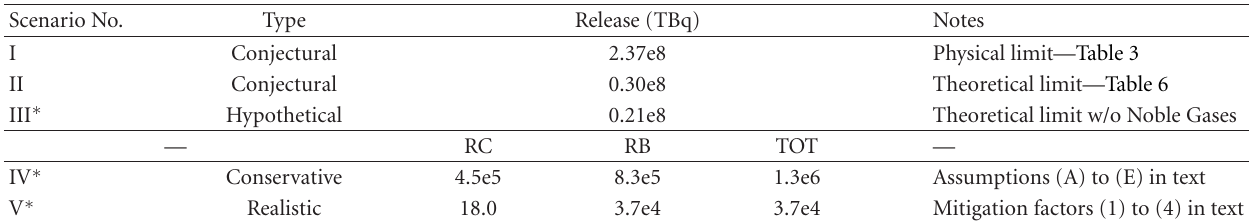
Table 7: Conjectural, hypothetical, conservative, and realistic radiological impact on environment of the Fukushima event. Scenario No.